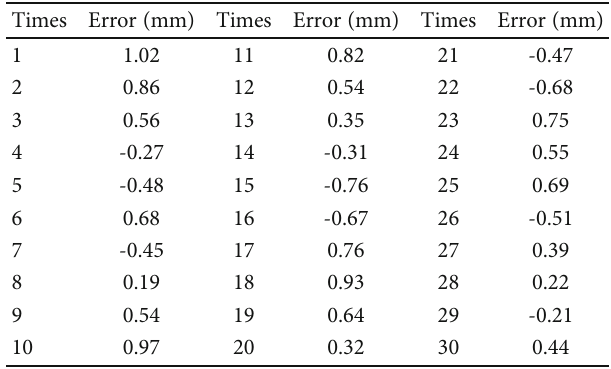
Figure 16: Line chart of error at di ff erent movement speeds. Table 8: Precision and accuracy at di ff erent speeds. Table 9: Positioning error of hydraulic rod at 1m tubing.